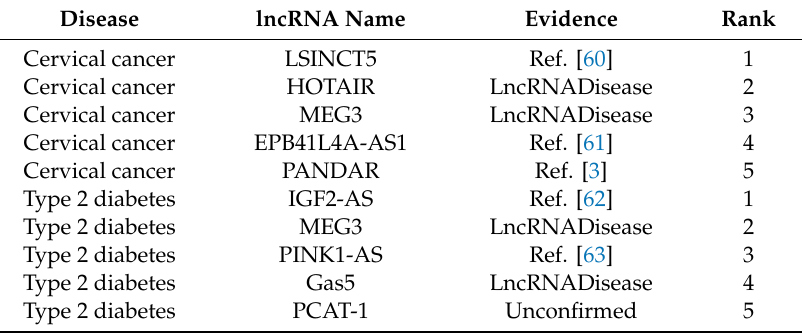
Table 1. The top five results predicted for cervical cancer and type 2 diabetes.